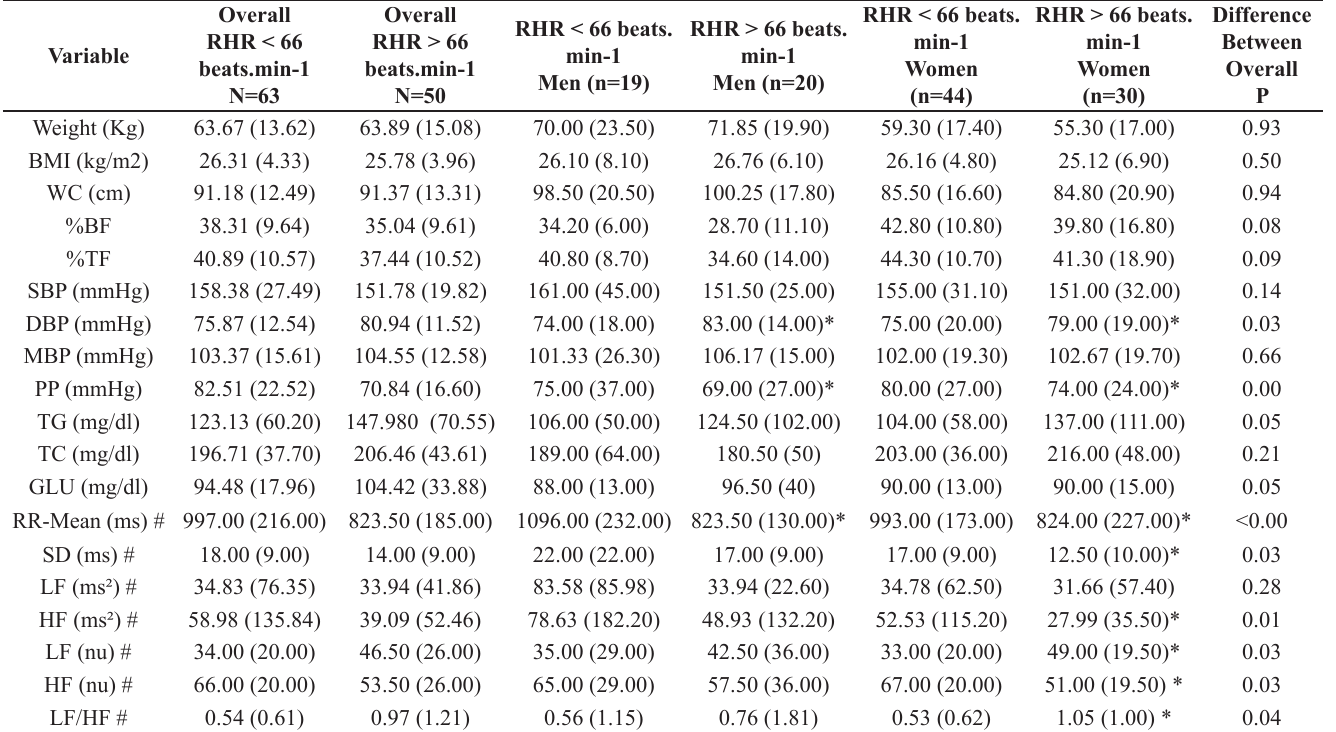
Table 2. Comparison of variables between higher and lower resting heart rate, anthropometric, metabolic, hemodynamic and heart rate variability according to gender in the elderly aged 80 years and over.